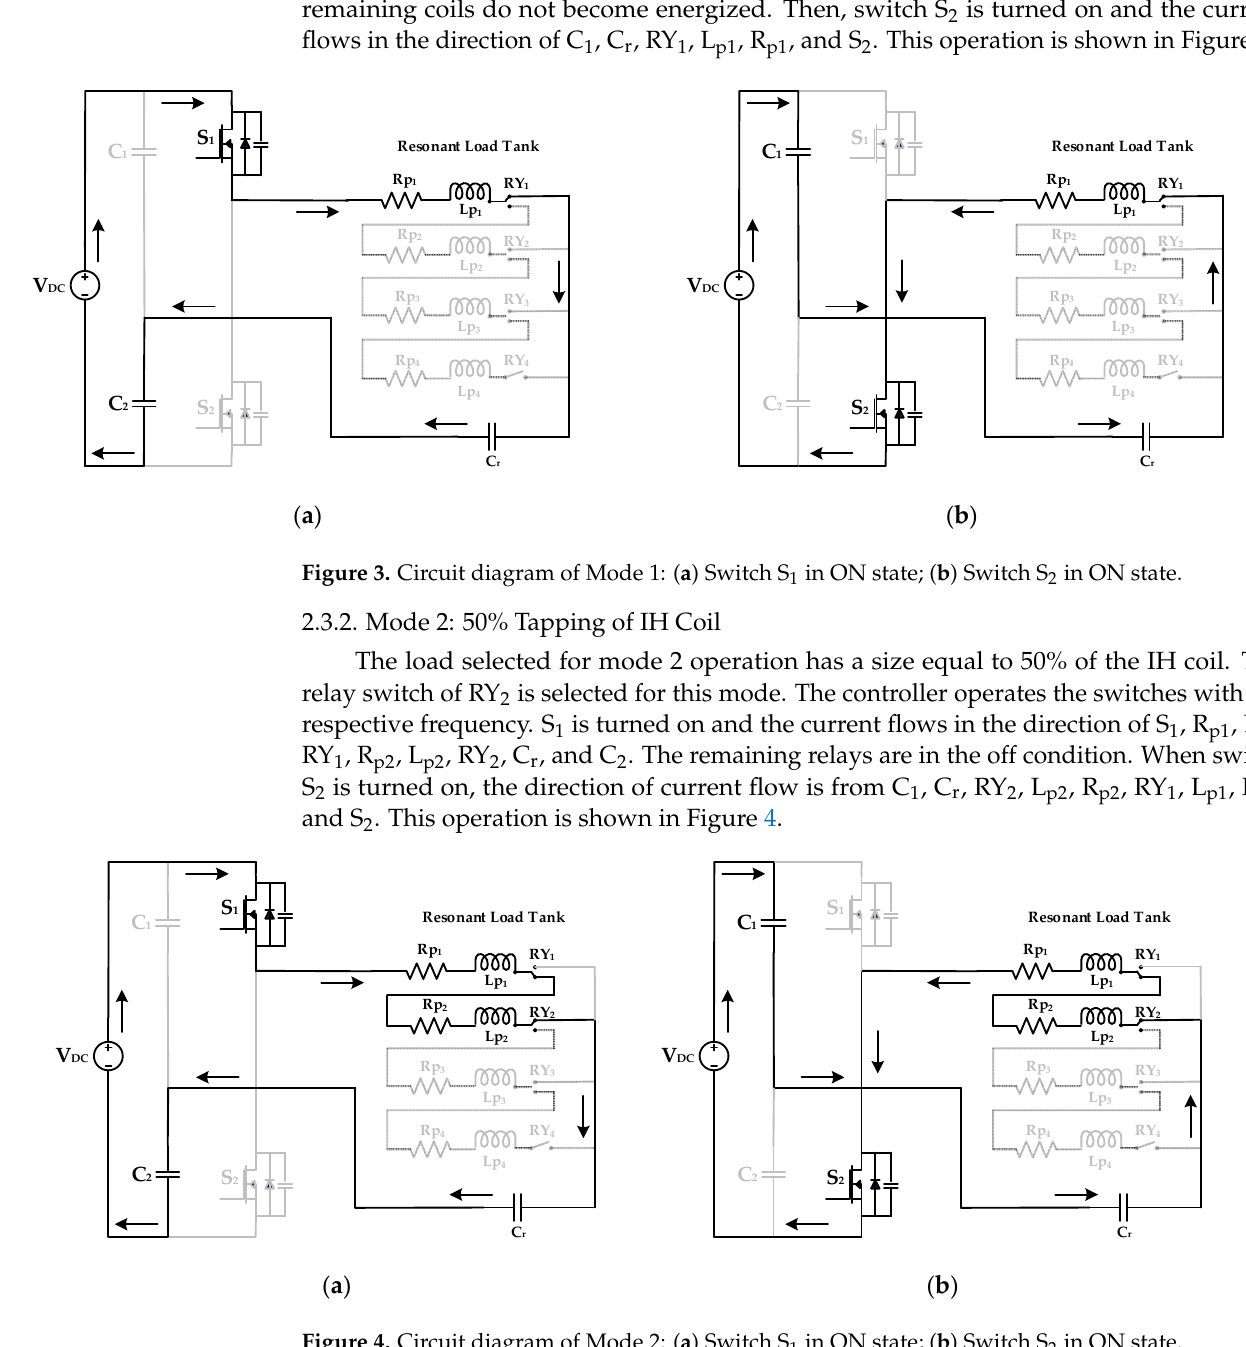
Figure 4. Circuit diagram of Mode 2: ( a ) Switch S 1 in ON state; ( b ) Switch S 2 in ON